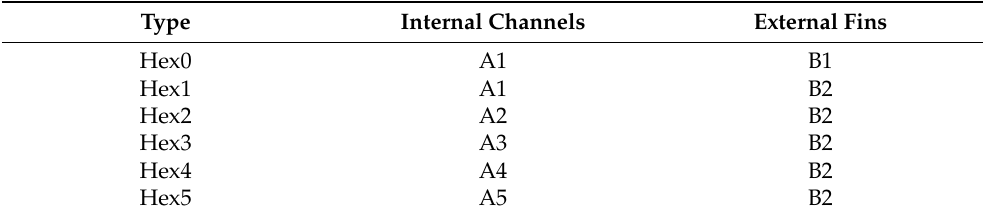
Figure 8. velocity distribution of A2~A5. ( a ) A2 (h = 2.5 mm); ( b ) A3 (h = 1.2 mm); ( c ) A4 (h = 1.2 mm); ( d ) A5 (h = 2.5 mm).